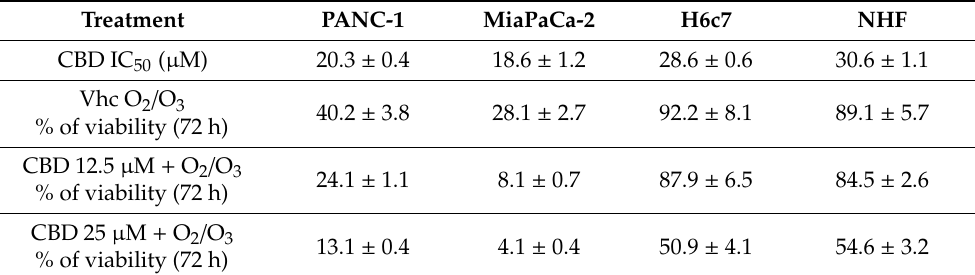
Table 1. IC 50 values and percentages of viability in PANC-1, MiaPaCa-2, H6c7 and NHF cell lines with CBD and O 2 / O 3 , alone or in combination, expressed as mean ± SD of three separate experiments.